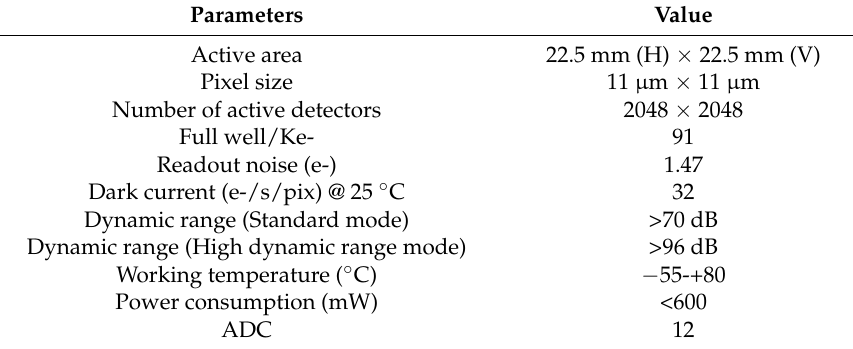
Table 1. Parameters of the CMOS detector.